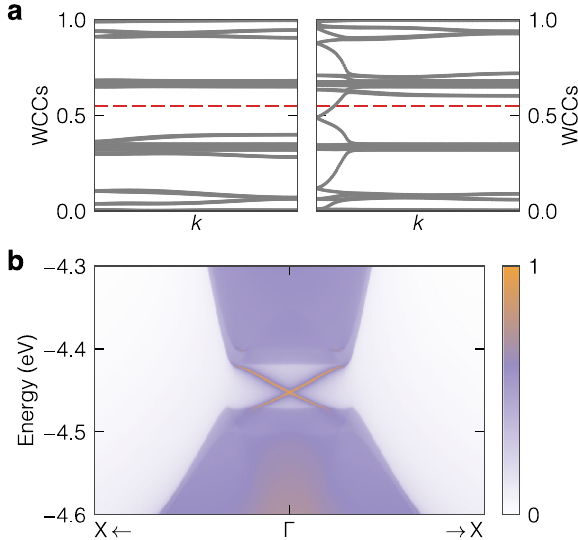
Fig. 4 Topological classi fi cation of the heterostructure. a Evolu- tion of the hybrid Wannier charge centers (WCCs) for the In 2 Se 3 /CuI heterostructure in the ↑ (left) and ↓ (right) polarization states. Any horizontal line such as, e.g., the red dashed line crosses an even (odd) number of times the WCCs in the former (latter) case. We thus have that when the polarization points from In 2 Se 3 to CuI ( ↑ , left) the system is trivial, while when it points from CuI to In 2 Se 3 ( ↓ , right) the heterostructure is a quantum spin Hall insulator (QSHI). b Edge spectral density for a semi-in fi nite ribbon of In 2 Se 3 /CuI in the QSHIs phase, where a pair of helical edge states crosses the bulk band gap.